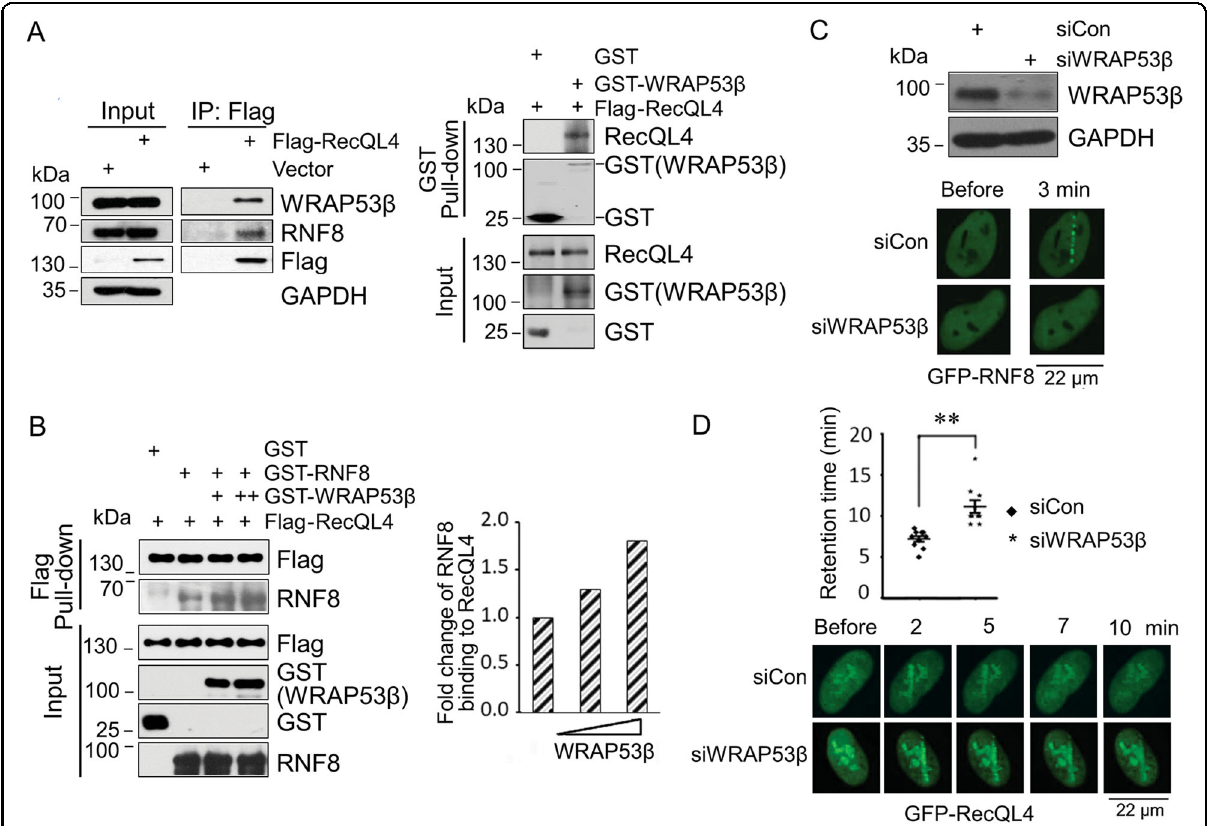
Fig. 5 WRAP53 β promotes the association between RNF8 and RecQL4. A RecQL4 interacts with WRAP53 β . Endogenous WRAP53 β was present in Flag immunoprecipitated fractions using the lysate of HEK293 cells transfected with Flag-RecQL4. Direct interaction between RecQL4 and WRAP53 β was further demonstrated by an in vitro pull-down assay using the puri fi ed recombinant GST-WRAP53 β to pull down Flag-RecQL4. B A markedly enhanced interaction between RecQL4 and RNF8 was observed upon the increased input of WRAP53 β protein assessed by an in vitro Flag pull-down assay, followed by the western blotting analysis. C Dynamic recruitment of GFP-RNF8 to DSBs induced by UV micro-point laser in WRAP53 β silenced U2OS cells relative to scrambled siRNA-transfected cells. D Dynamic recruitment of GFP-RecQL4 to DSBs in scrambled siRNA or WRAP53 β siRNA-transfected U2OS